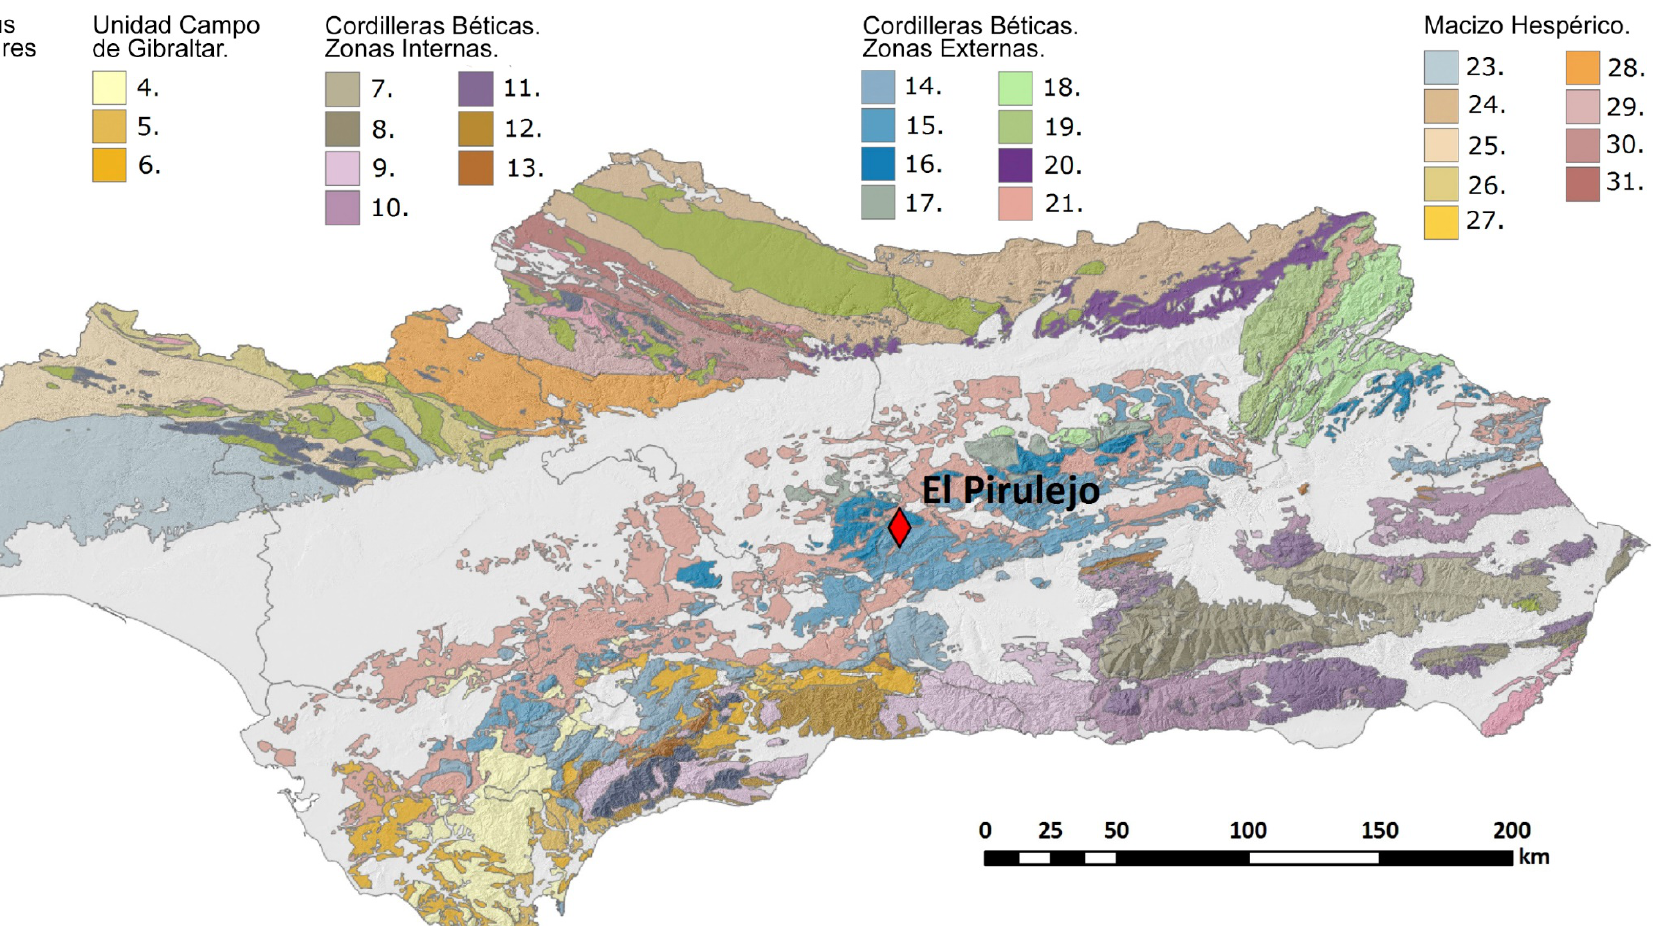
Figure 3. Geological maps. Baetic System based in Vera 2004. 1. Volcanic. 2. Basic Plutonics. 3. Acid plutonics. 4. Aljibe Unit. 5. Algeciras Unit. 6. Other Units. 7. Nevado- Filabride Complex. 8. Nevado-Filabride Complex. Alpujarride Complex. 10. Alpujarride Complex. 11. Alpujarride Complex. 12 Malaguide Complex. 13. Dorsaliano Complex. 14. Internal Subbetic. 15. Subbetic Medium. 16. Subbetic External. 17. Intermediate Units. 18. Internal Prebetic. 19. External Prebetic. 20. Tabular Covarage. 21. Common Terms. 23. Area sub-portuguesa. 24. Central-Iberian Zone. 25. Sierra de Aracena Dominian. 26. Domain Elvas-Cumbres Mayores. 27. Domain Olivenza- Monesterio. 28. Domain Zafra-Alanis-Córdoba. 29. Sierra Albarrana Domain. 30. Domain Valencia de Torres-Cerro. 31. Obejo-Valsequillo Journal of Lithic Studies (2016) vol. 3, nr. 2, p. 91-107 doi:10.2218/jls.v3i2.1872